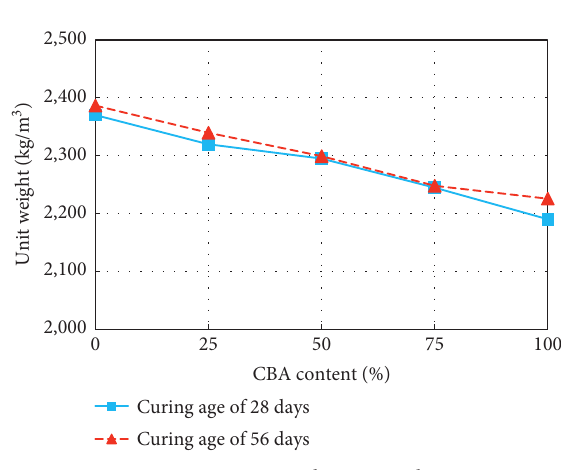
Figure 5: Unit weight test results.